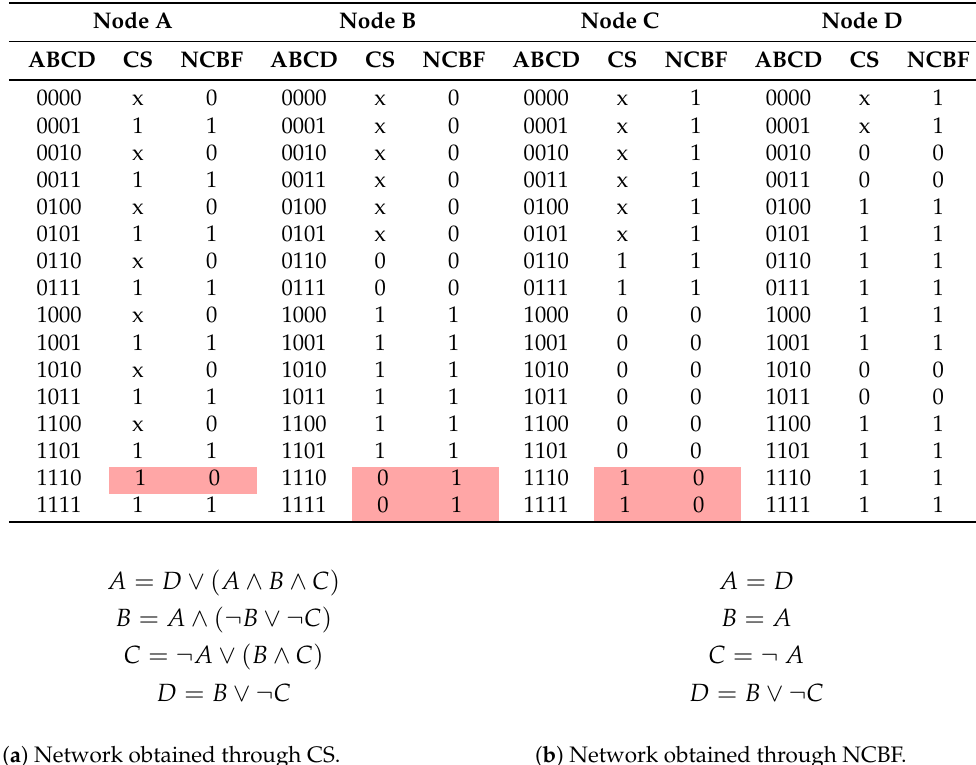
Figure 4. Expressions of the networks obtained through CS and